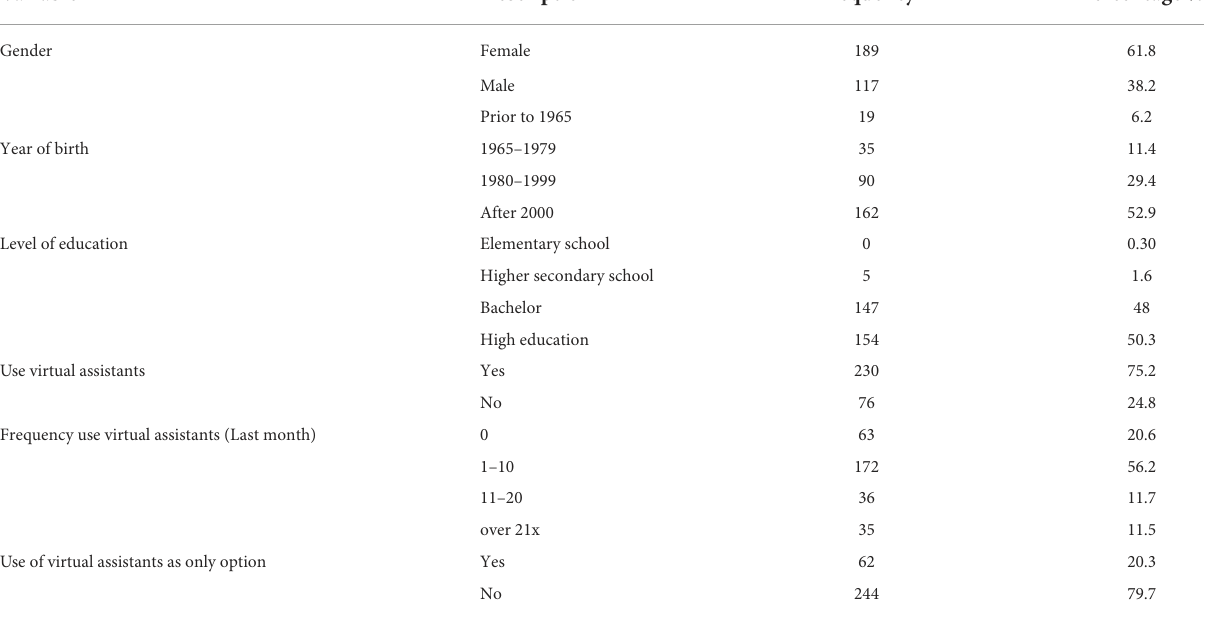
TABLE 4 Survey feature